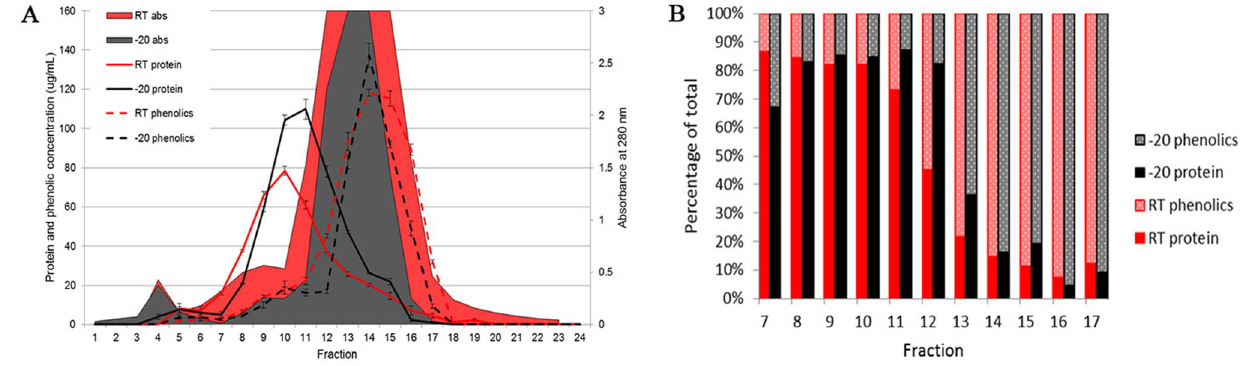
Figure 4. Comparative distribution and quantitation of proteins and polyphenols in protein-polyphenol complexes, A SEC profile (at A 280 nm) of the size distribution of protein-polyphenol complexes in buckwheat honey (H177) stored at 2 20 u C (black line) and at room temperature (red line), and the distribution of proteins (as estimated by Bradford method, black line, 2 20 u C, red line, RT) and polyphenols (as estimated by Folin-Ciocalteu method, black dotted line, 2 20 u C and red dotted line, RT) ( A ). The protein to polyphenol ratio in fractions expressed as percentage of the total mass ( B ).